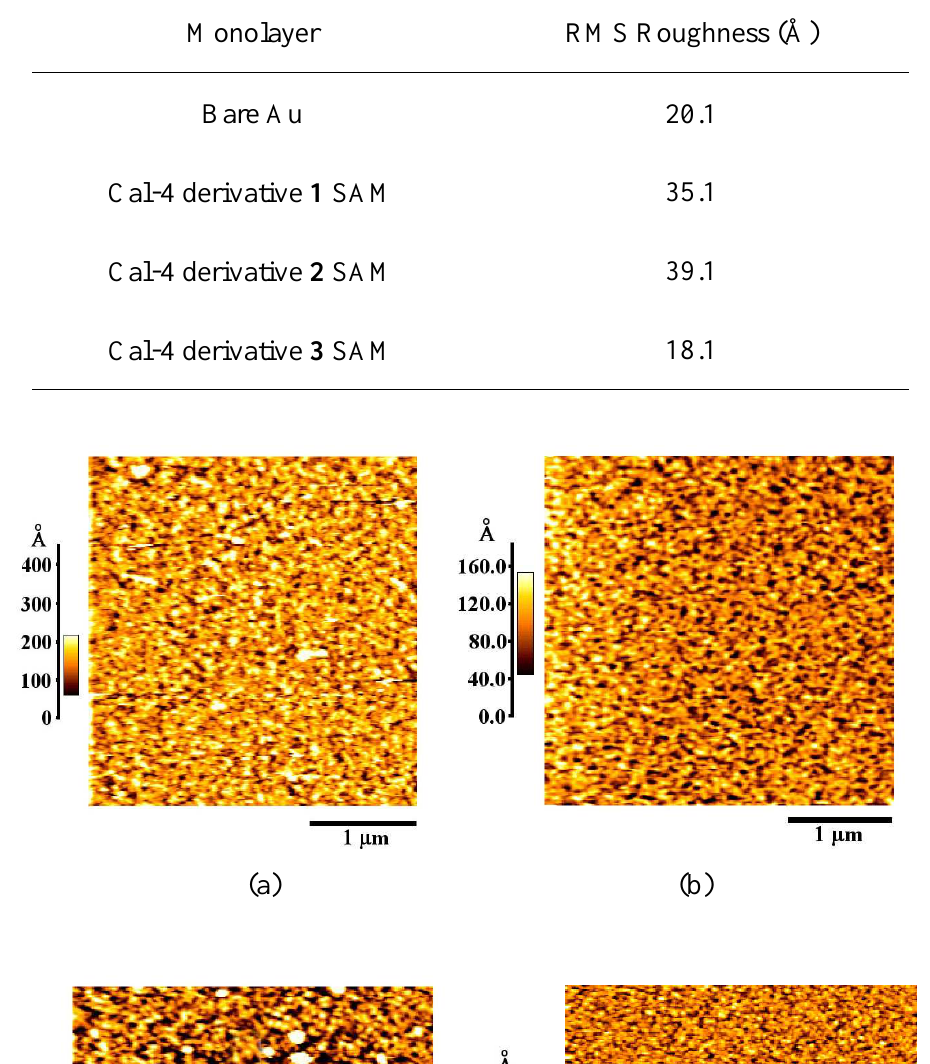
Table 2 . RMS Roughness of Cal-4 derivative SAMs on Au surface.